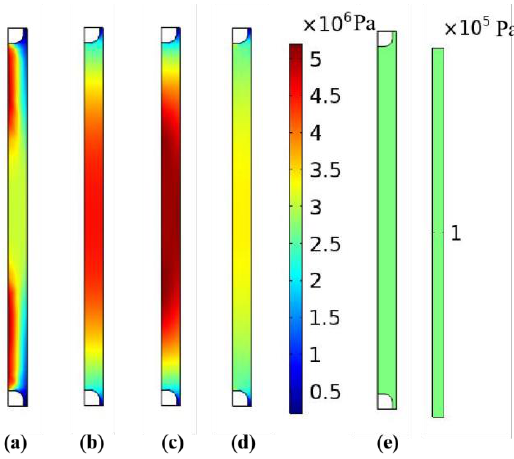
Figure 6. Pressure change cloud diagram. ( a ) 5 µ s, ( b ) 20 µ s, ( c ) 40 µ s, ( d ) 70 µ s, ( e ) 205 µ s.